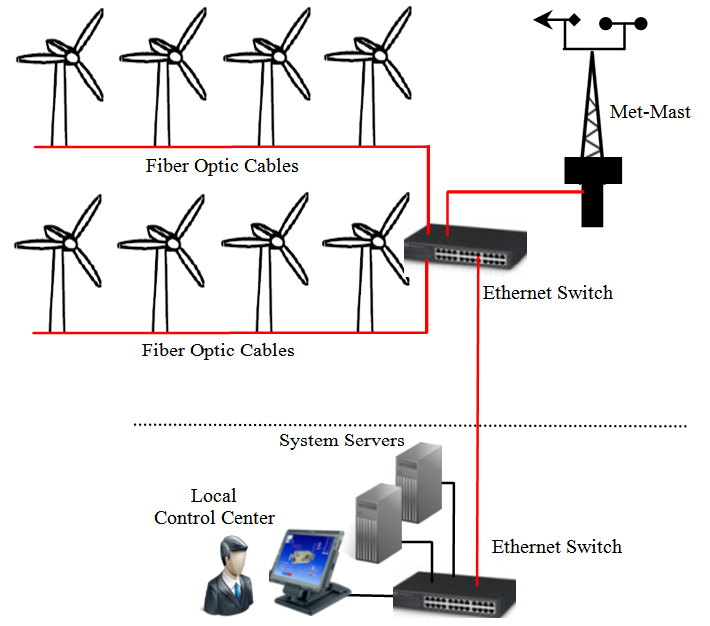
Figure 5. Structure of farm area network